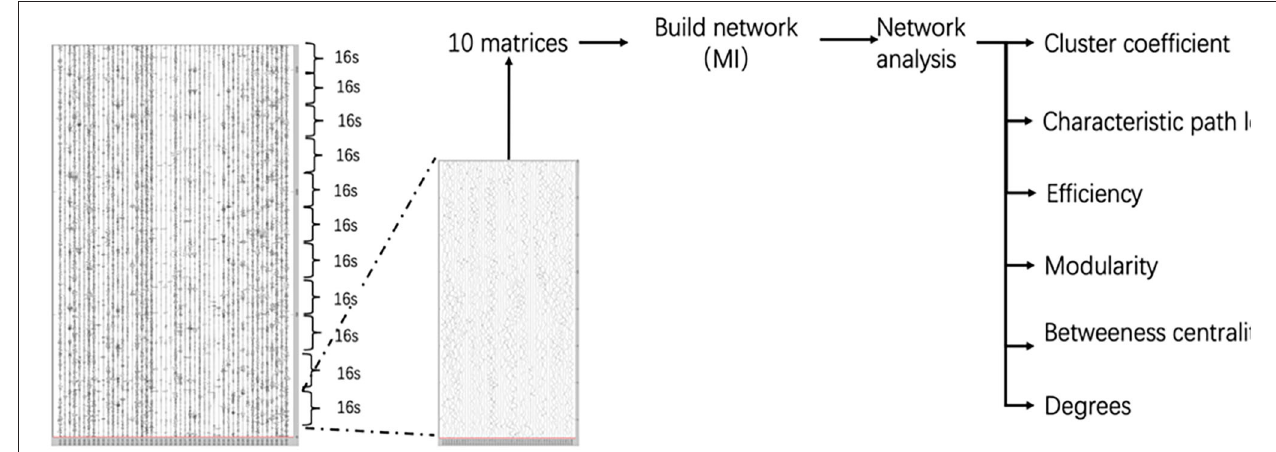
FIGURE 2 | Network analysis